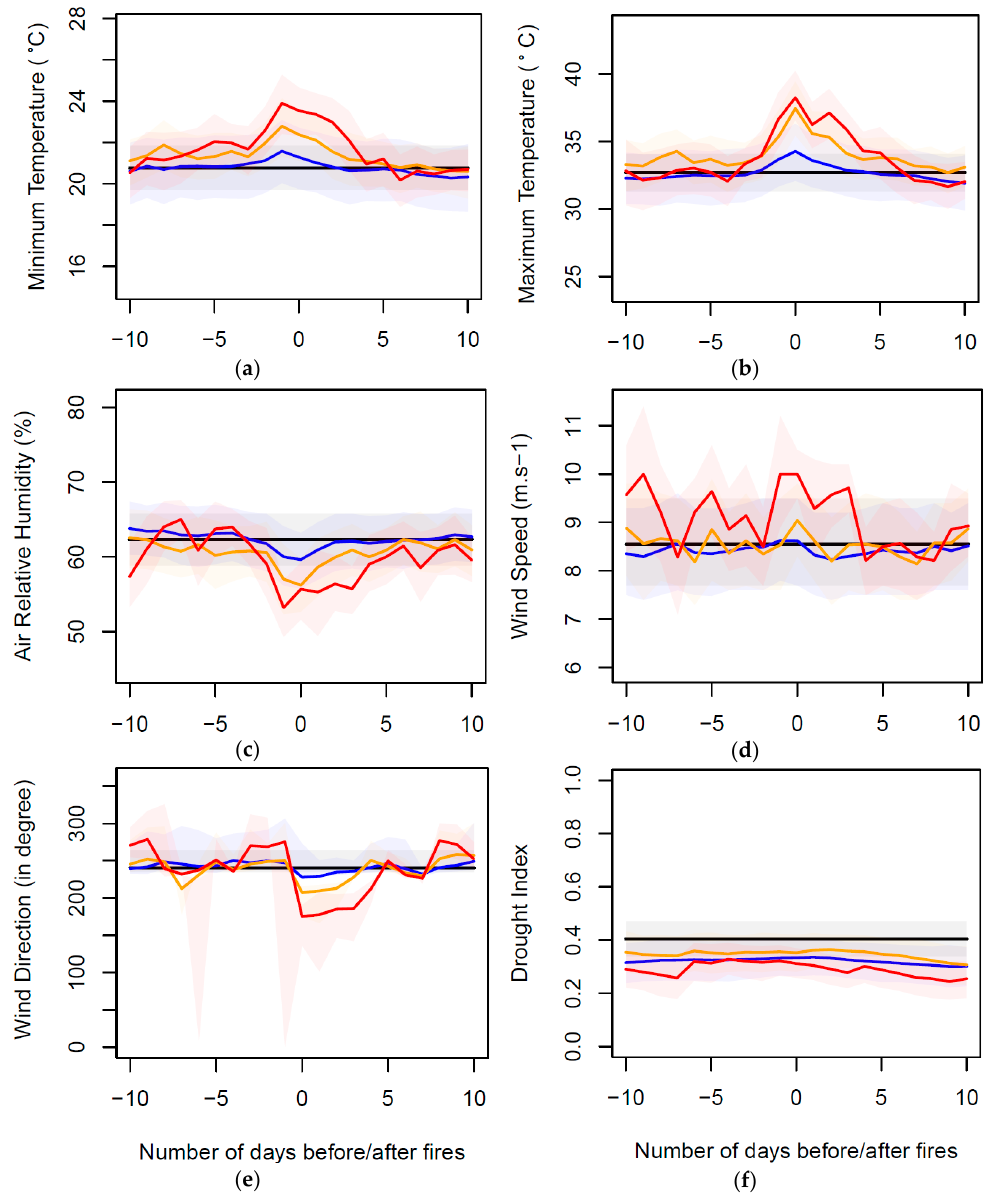
Figure 2. Mean daily weather values from 10 days before to 10 days after fire events for fire size classes >1 ha (blue), >100 ha (yellow), >400 ha (red), and all days during the July–August fire season (black), for daily climate variables of ( a ) minimum temperature (T min in °C), ( b ) maximum temperature (T max in °C), ( c ) relative air humidity (HR in %) ( d ) wind speed (WS in m·s − 1 ), ( e ) wind direction (WDIR in degree deviation from North), and ( f ) drought index (DI) varying from 0 (completely dry) to 1 (full moisture) soil water conditions. Colored shaded areas correspond to the 90% confidence interval obtained from 1000 bootstrapped subsamples.